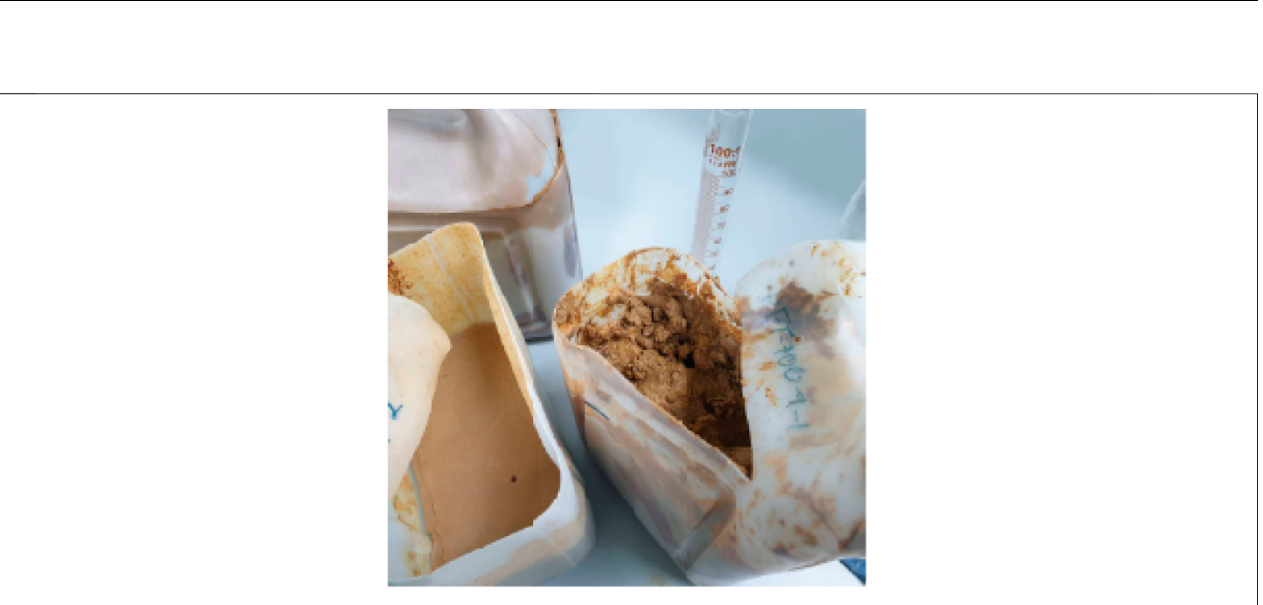
FIGURE 10 | Products obtained from the pyrolysis of PET